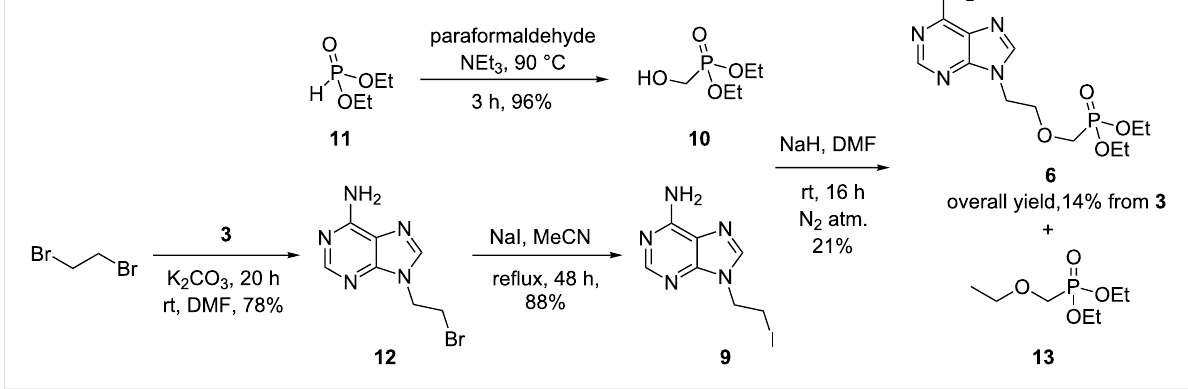
Scheme 2: Forward synthesis of 6 from 9 and 10 .